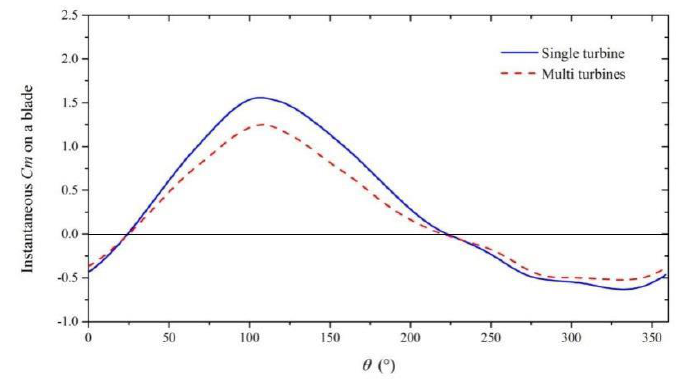
Figure 15. Effects of adjacent turbines on the instantaneous torque on a blade at TSR = 1.0, l = 1.00 D and φ = 45°.